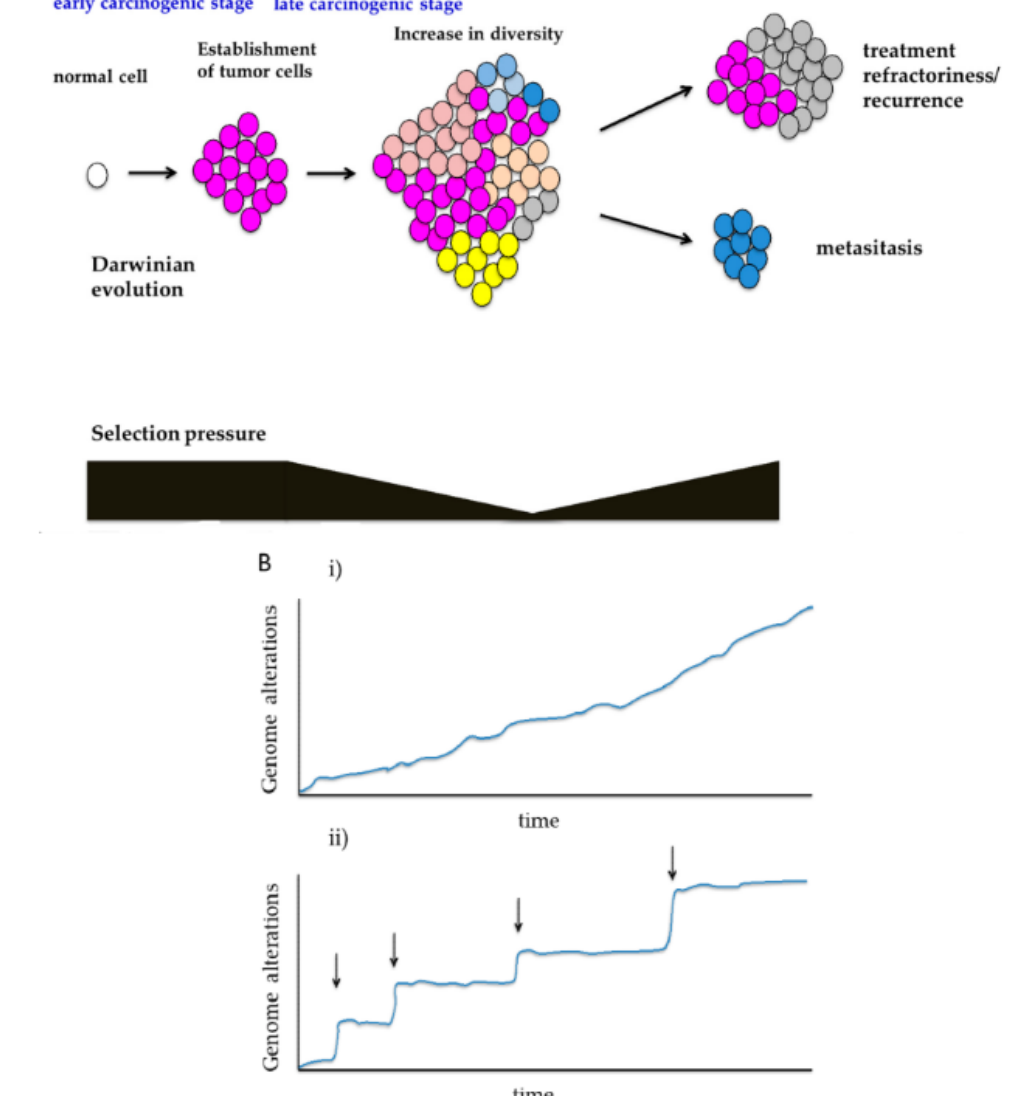
Figure 3. Temporal changes in diversity during cancer genome evolution. ( A ) Changes in selection pressure during carcinogenesis: Before the establishment of parental clones containing the minimum required abnormal driver genes, cancer cells are under a certain level of selection pressure. Afterwards, selection pressure is weakened, and genetic diversity in the lesions increases. In refractory or metastatic lesions, many different selection pressures are generated. ( B ) Diversity in adaptive evolution: (i) Sequential evolution: the exemplary pattern of adaptive evolution in which phenotypes are gradually obtained by spontaneous mutations and other processes. (ii) Punctuated evolution: the exemplary pattern of adaptive evolution characterized by discontinuous and distinctive acquisition of phenotypes